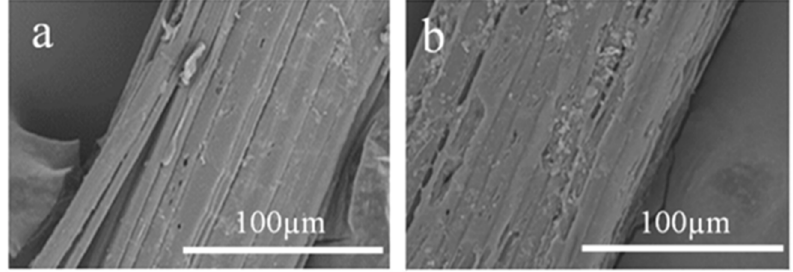
Figure 2. SEM of ( a ) raw and ( b ) treated jute fiber under 1000× magnification.